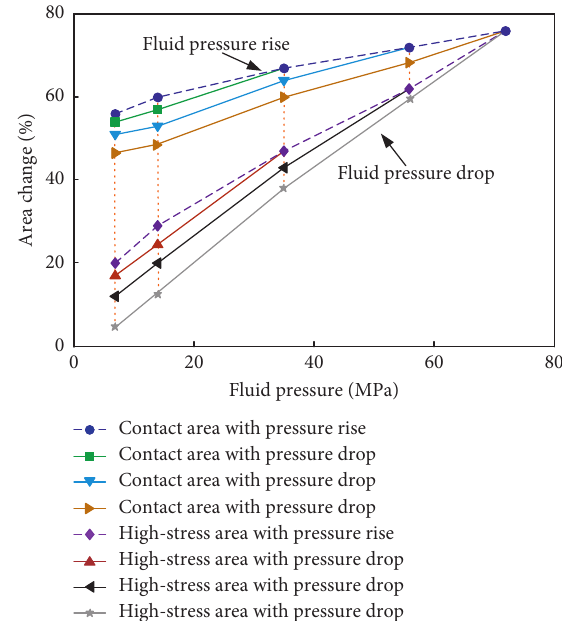
Figure 10: Contact area and high-stress zone area with the in- creased and decreased fluid pressure.